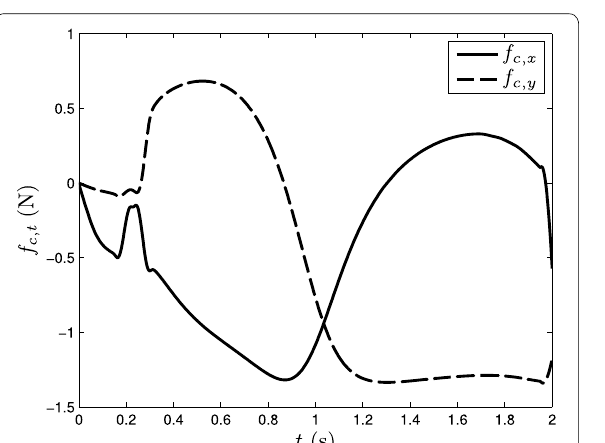
Fig. 13 Tangential frictional forces at the contact interface of the soft tip and object